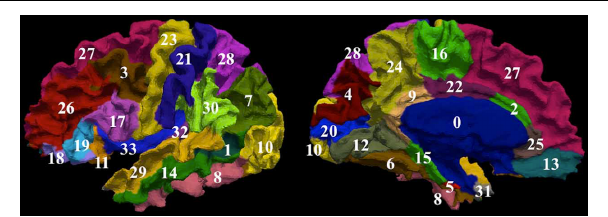
Table 3 . A separate atlas representation was generated for the